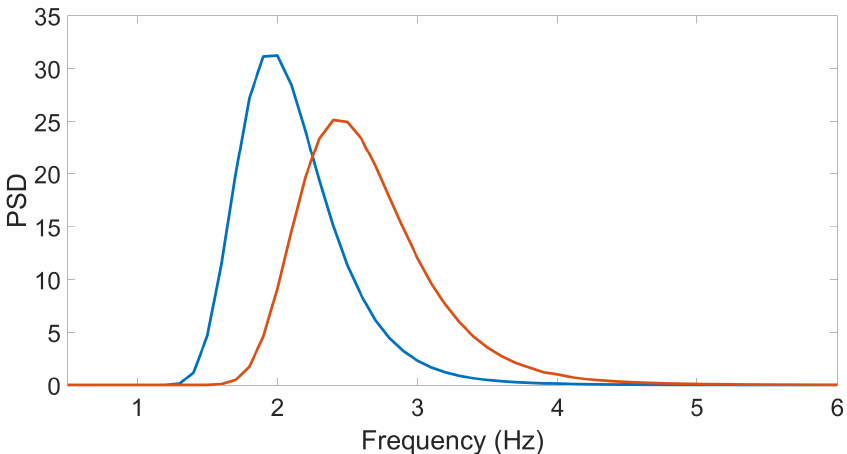
Figure 2. PSD-Frequency projection of wavelet spectrums of two sinusoidal signals: blue is 2 Hz, orange is 2.5 Hz.